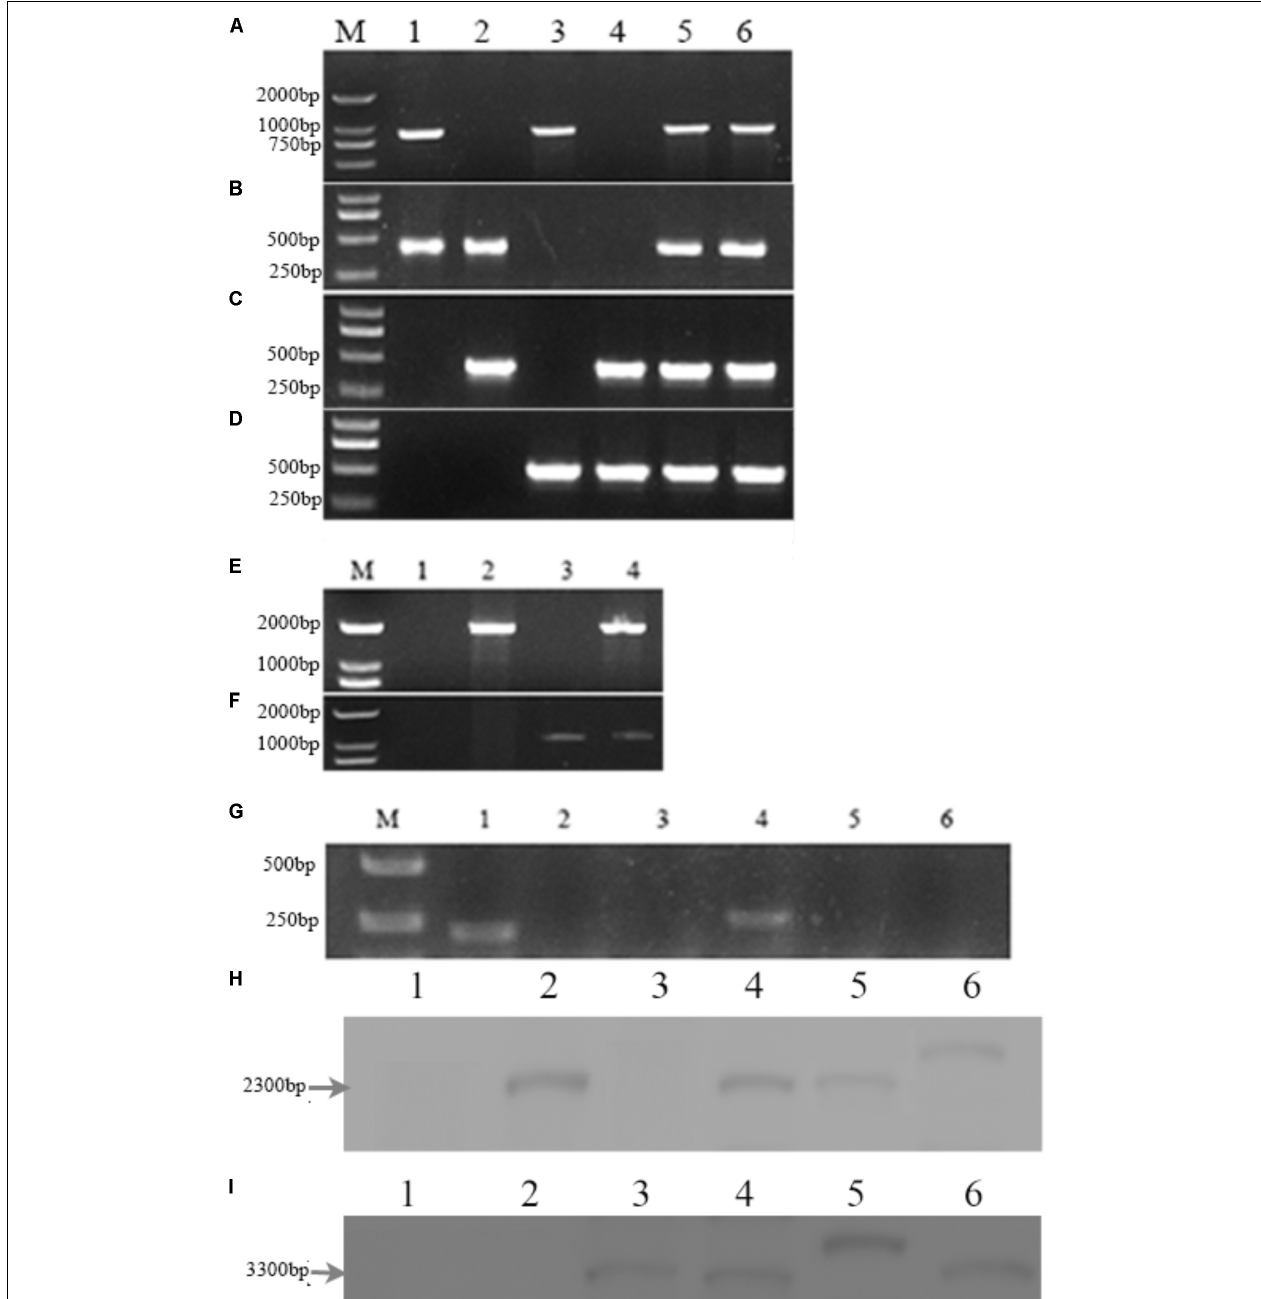
FIGURE 2 | Deletion of the Mrmep1 and Mrmep2 gene in M. robertsii . (A–D) PCR analysis of the deleted genes using the primers Mrmep1 -F and Mrmep1 -R (A) , the primers Mrmep2 -F and Mrmep2 -R (B) , the primers bar -F and bar -R (C) , and the primers ben -F and ben -R (D) . M, Marker; 1, WT; 2, (cid:49) Mrmep1 ; 3, (cid:49) Mrmep2 ; 4, (cid:49) Mrmep1 (cid:49) Mrmep2 ; 5, cp (cid:49) Mrmep1 ; 6, cp (cid:49) Mrmep2 . (E,F) PCR analysis for the bar (E) or ben (F) genes. M, Marker; 1, WT; 2, (cid:49) Mrmep1 ; 3, (cid:49) Mrmep2 ; 4, (cid:49) Mrmep1 (cid:49) Mrmep2 . (G) RT-PCR analysis for the deleted genes. M, Marker; 1 and 4, WT; 2, (cid:49) Mrmep1 ; 3 and 6, (cid:49) Mrmep1 (cid:49) Mrmep2 ; 5, (cid:49) Mrmep2 . (H,I) Southern blotting hybridization with bar or ben gene probes. 1, WT; 2, (cid:49) Mrmep1 ; 3, (cid:49) Mrmep2 ; 4, (cid:49) Mrmep1 (cid:49) Mrmep2 ; 5, cp (cid:49) Mrmep1 ; 6, cp (cid:49) Mrmep2 . Further information on primers can be found in Table 1